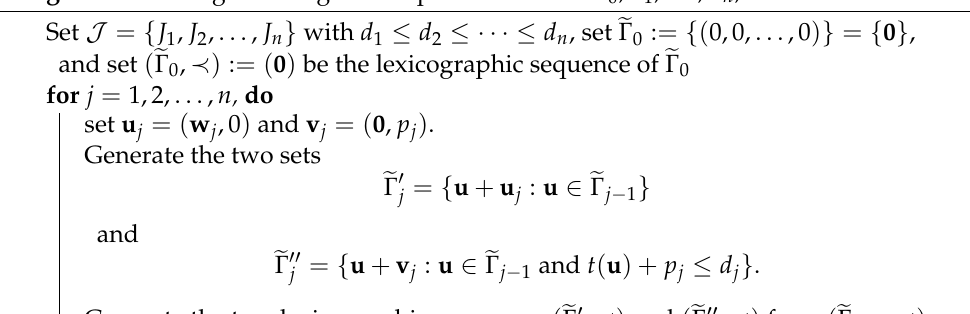
Algorithm DP2 to generate the simplified versions (cid:101) Γ 0 , (cid:101) Γ 1 , . . . , (cid:101) Γ n , (cid:101) Γ . Algorithm 2: For generating the simplified versions (cid:101) Γ 0 , (cid:101) Γ 1 , . . . , (cid:101) Γ n , (cid:101)